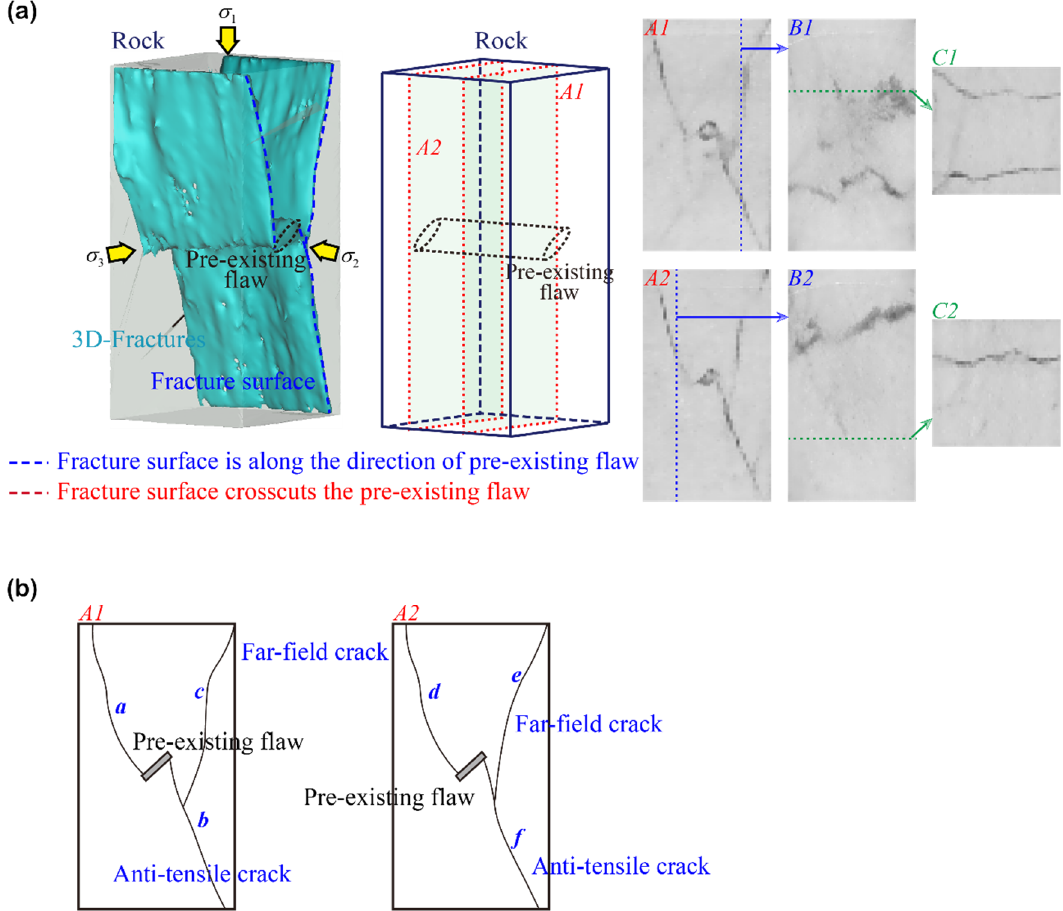
Figure 9. ( a ) Distribution of internal fissures in rocks with prefabricated fissures under the TTT-c2 condition; ( b ) Various crack types from a single fissure identified.